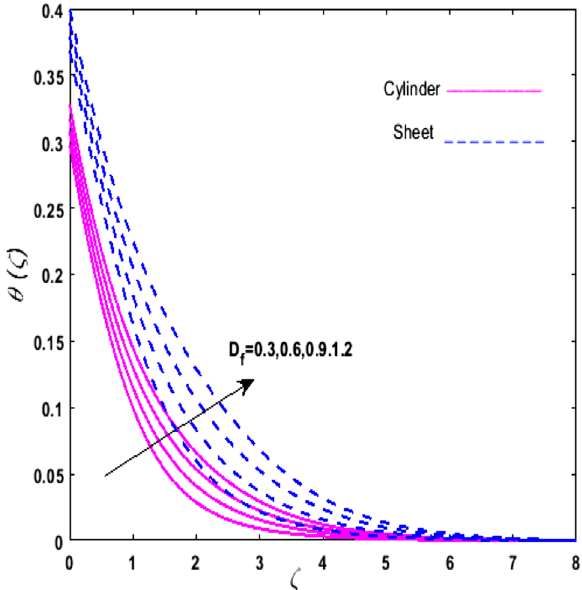
Figure 12. Upshot of D f on θ(ζ) .